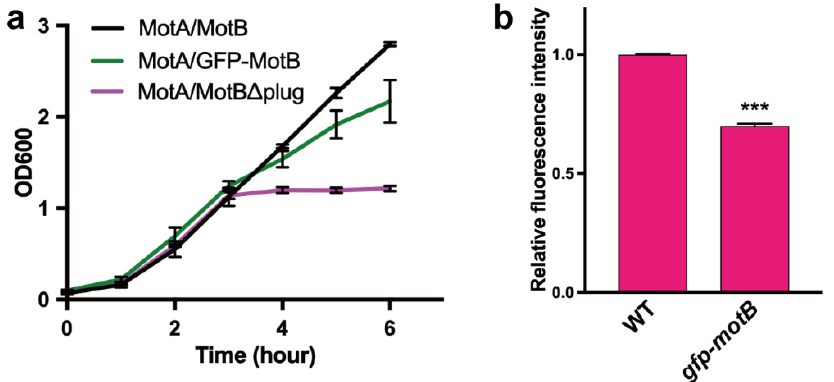
Figure 3. E ff ect of the GFP tag attached to the N-terminus of MotB on the proton channel activity of the MotA / MotB complex. ( a ) Growth curves of the SJW1368 strain carrying pYC20 (MotA / MotB, black line), pYVM042 (MotA / GFP-MotB, green line) or pYC109 [MotA / MotB ( ∆ plug), magenta line]. The cells were grown in LB at 30 ◦ C with shaking for 3 h, and then arabinose was added to a final concentration of 0.2%. Error bars represent standard deviations. ( b ) Fluorescence intensities of mNectarine in SJW1103 (WT) harboring pBAD-mNectarine and YVM003 ( gfp-motB ) carrying pBAD-mNectarine. The cells were grown overnight in LB at 30 ◦ C with shaking, and then the fluorescence intensities of mNectarine were measured using a fluorescence spectrophotometer. The fluorescence intensities measured in the YVM003 strain were normalized to those of the SJW1103 strain. Statistical analysis was carried out using a two-tailed t -test (*** p < 0.001). Error bars represent standard deviations.